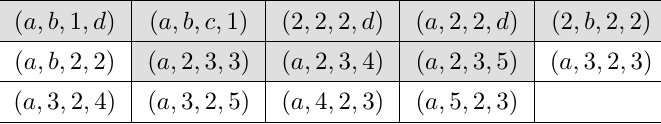
Table 20 . Infinite sequences of type XVI singularities. The gray entries are either reducible to previous types or have at least one of c, d = 1 , which gives trivial 1-form symmetry. This table is adapted from